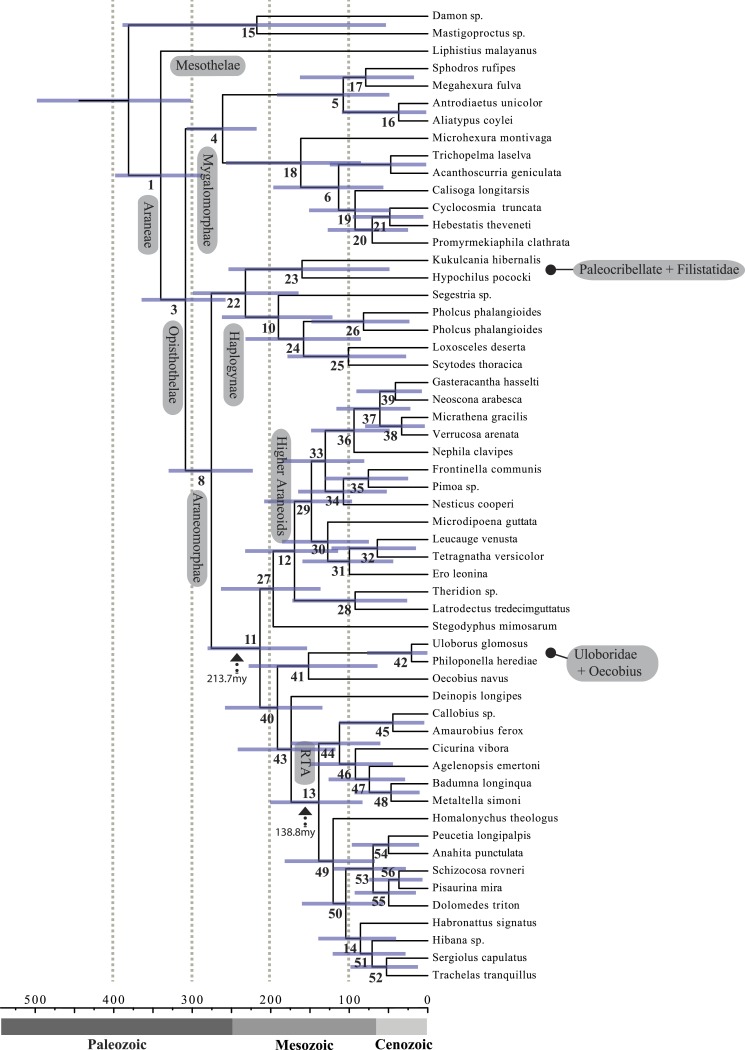
Chronogram resulting from two Bayesian MCMC runs performed in BEAST showing estimated divergence time for major spider lineages.Time scale on x axis; node point estimates and 95% confidence intervals (blue bars) are reported in Table 2. Node numbers correspond to numbering scheme used in Tables 1 and 2.